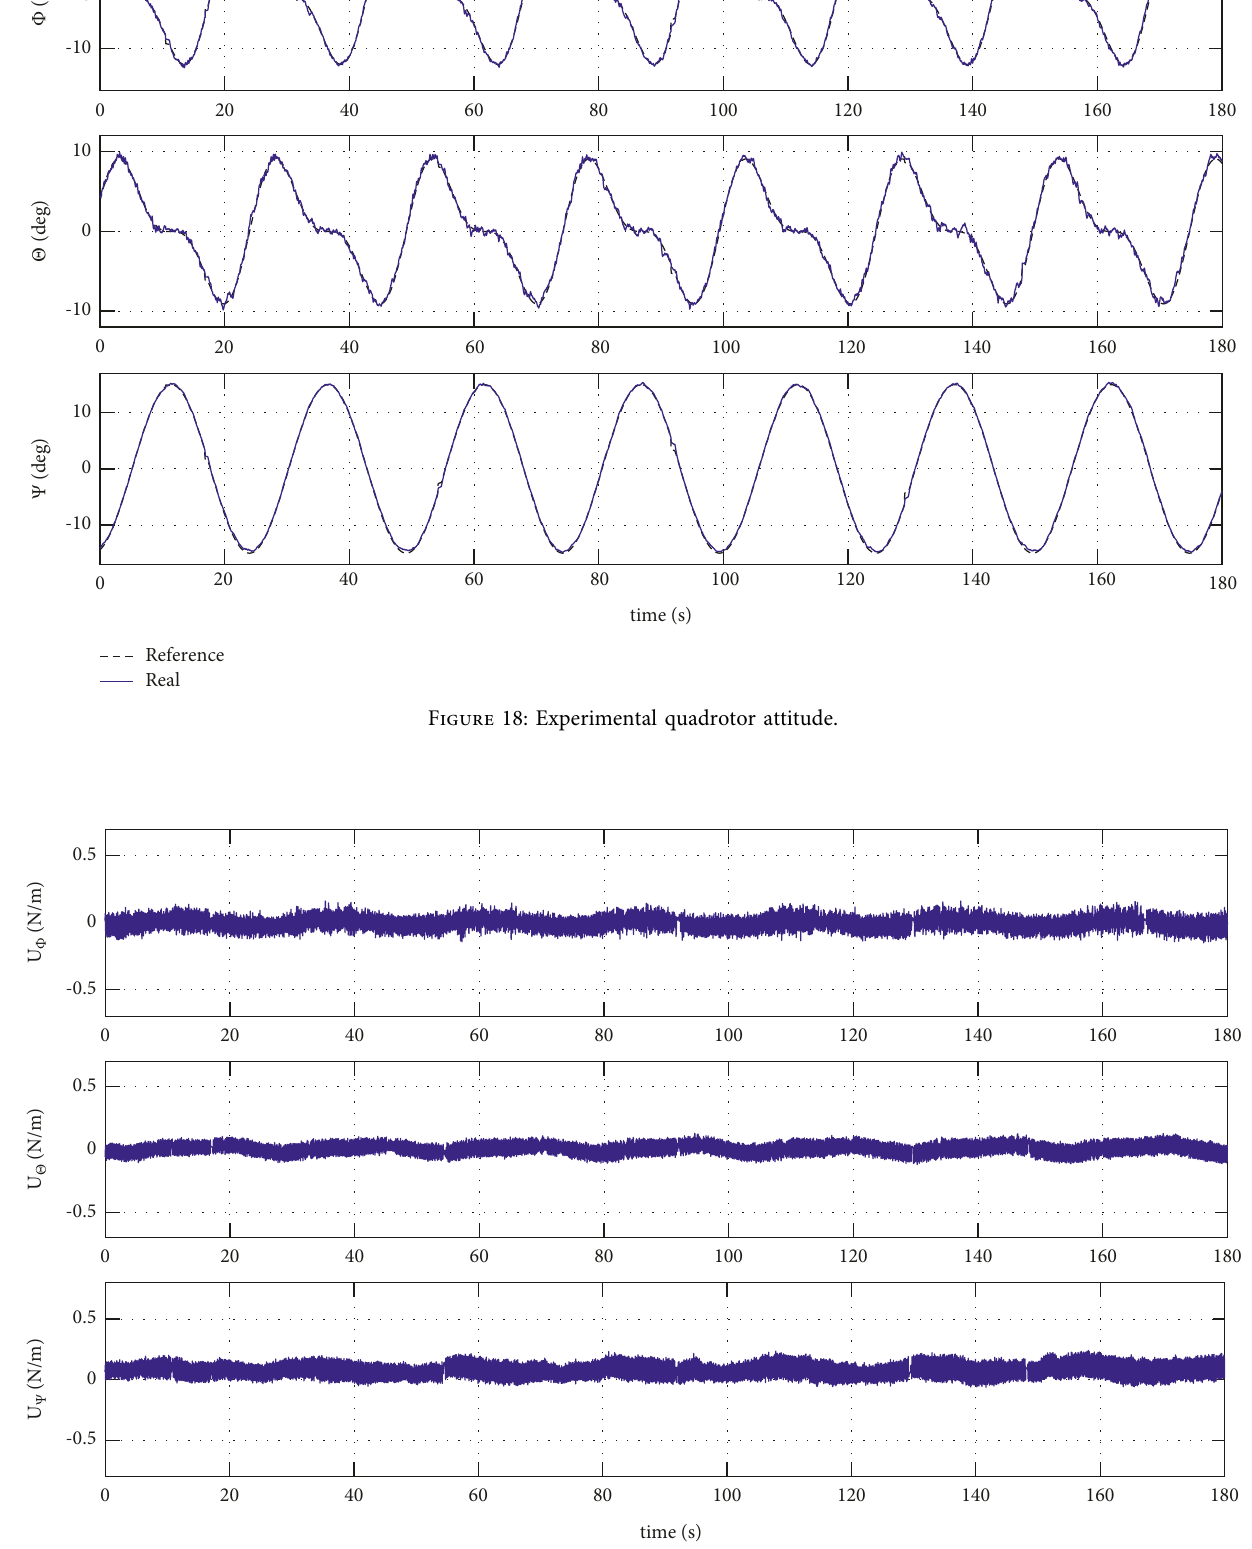
Figure 19: Control